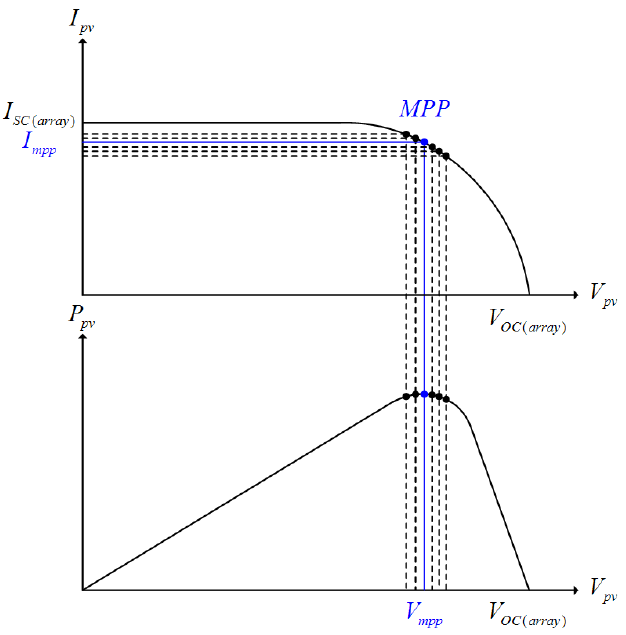
Figure 6. Operating point of the PV